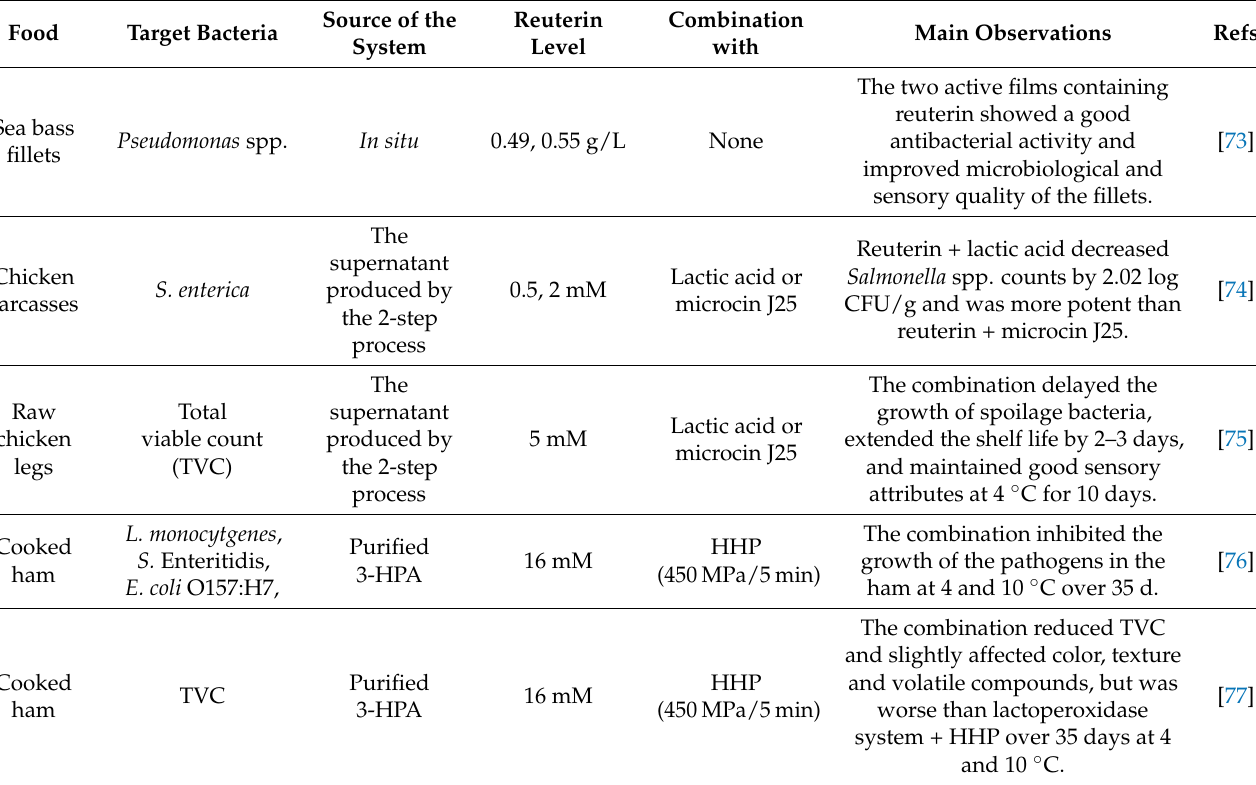
Table 3. The use of the reuterin system as preservative in meat and fish